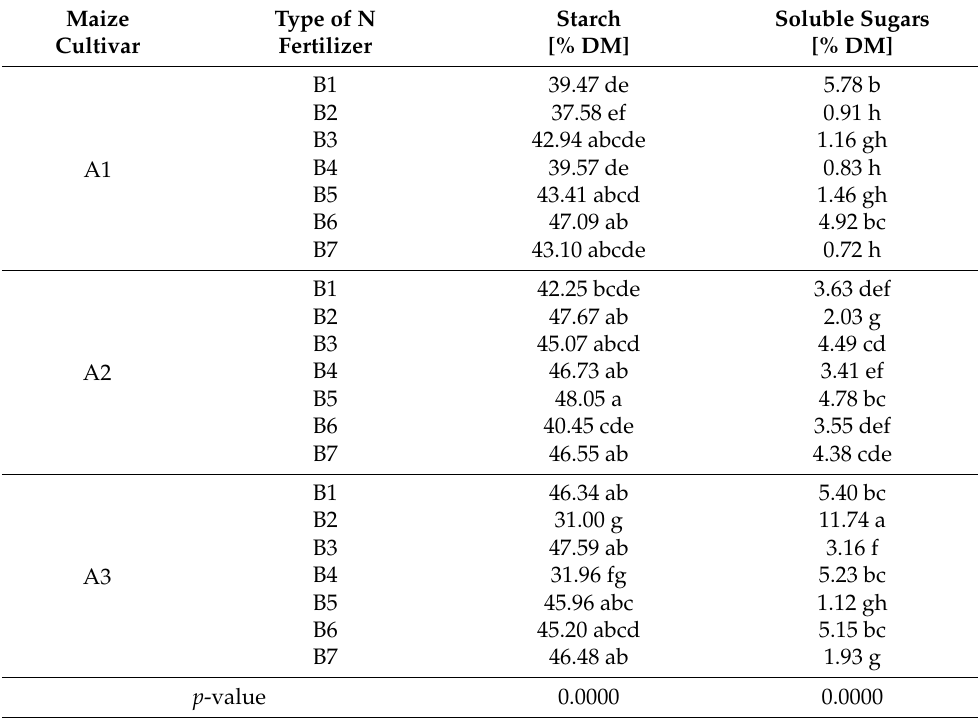
Table 7. Average values of non-structural carbohydrates for the combination of cultivar (A) and fertilizer (B).